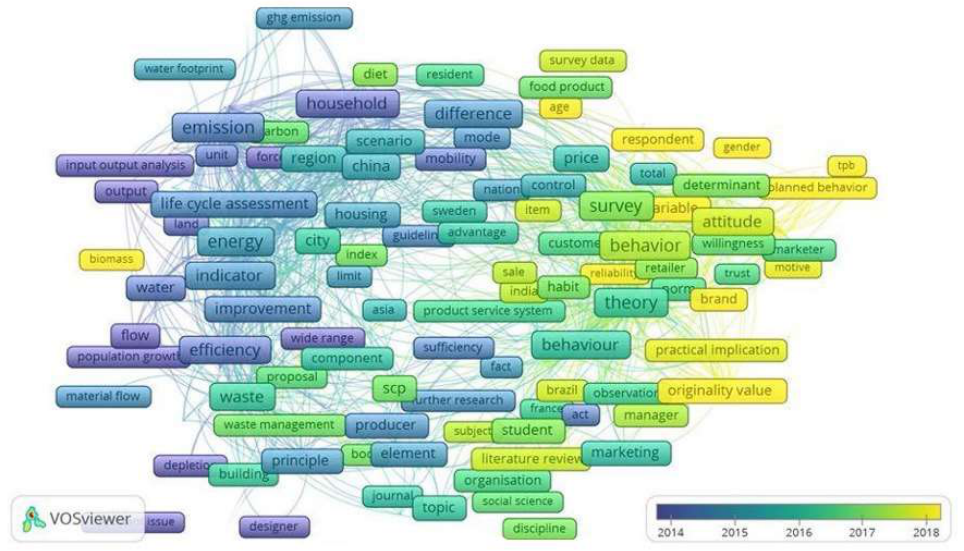
Figure 2. The overlay visualization of co-occurrence of keywords “sustainable consumption”, “B2B”, or “Industrial” based on the SCOPUS articles, which was created by the authors using VOSviewer (version 1.6.17).